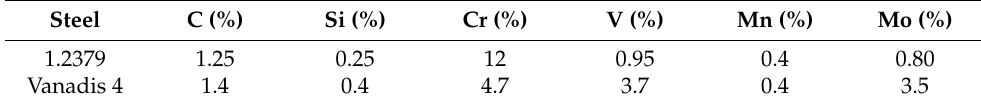
Table 1. Chemical composition of the steels studied in this work